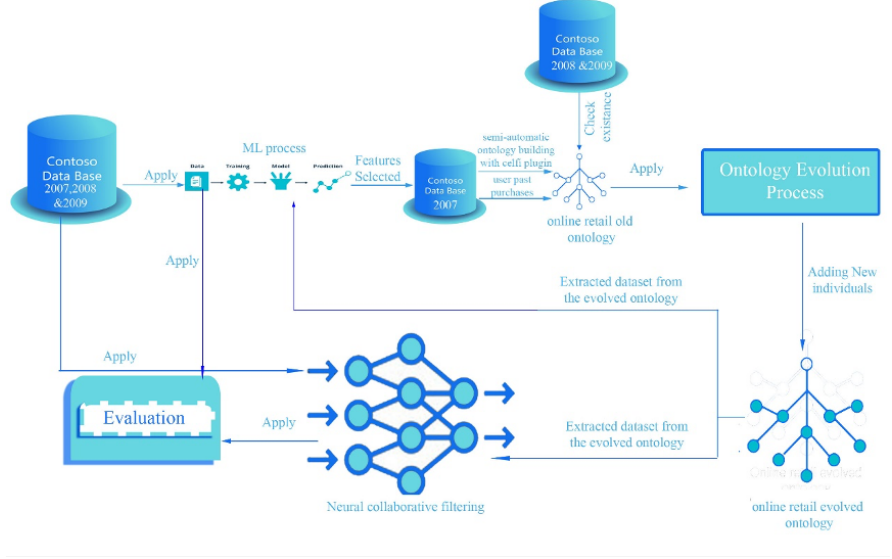
Figure 4. Detail of the integration of ontology evolution, ML, and NCF. This shows that the evolved ontology is one of the inputs for NCF.